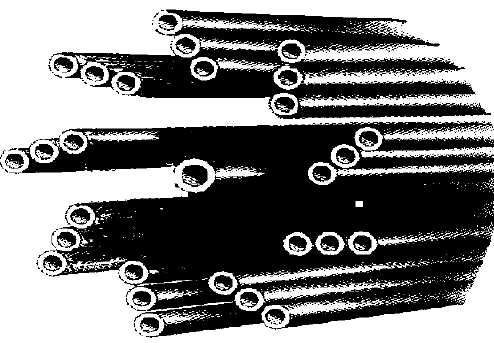
Figure 1. Structure of microtubules forming a centriole